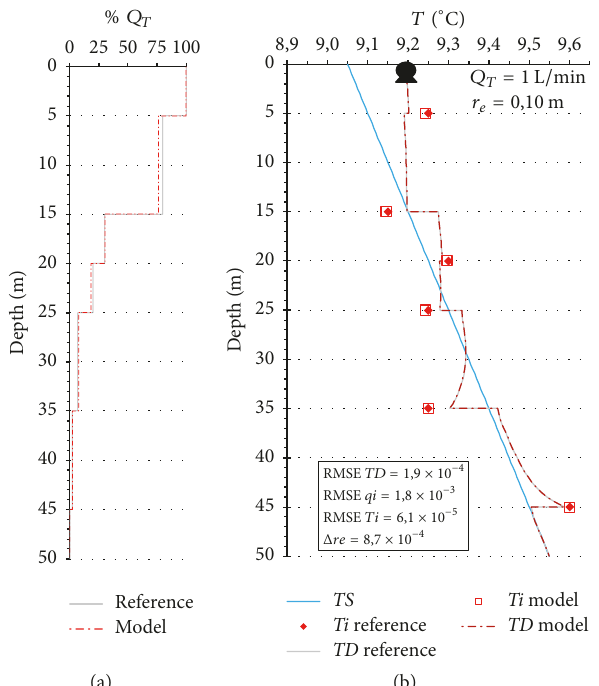
Figure 7: Results of 𝑇 𝐷 (𝑧) modelling with the heat budget at 𝑄 𝑇 = 1L/min. (a) Flow-depth distribution; (b) dynamic temperature profiles ( 𝑇 𝐷 (𝑧) ) and temperatures of inflows ( 𝑇 𝑖 (𝑧) ).